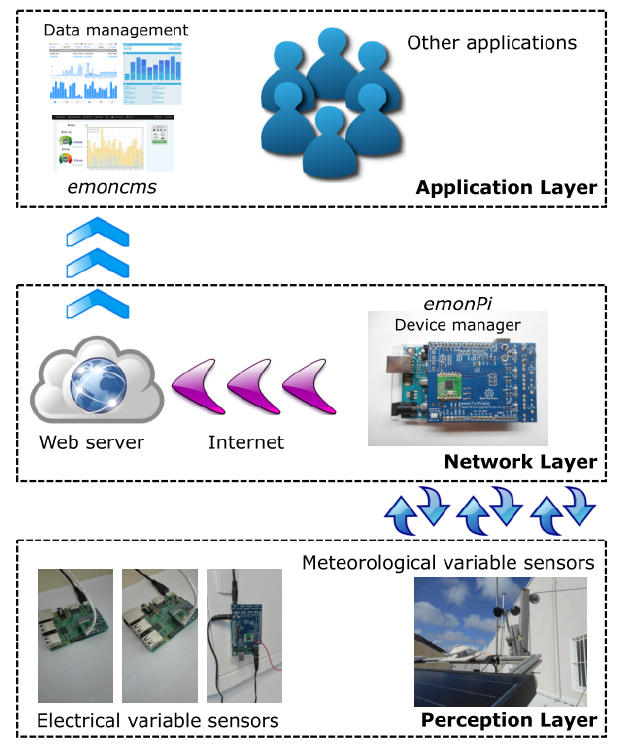
Figure 6. Three layers of Internet of Things